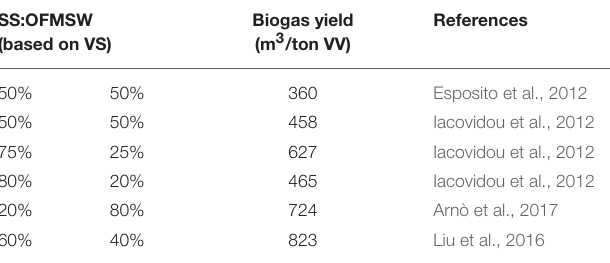
TABLE 8 | Reference values for co-digestion productivity at different SS:OFMSW ratios. SS:OFMSW (based on